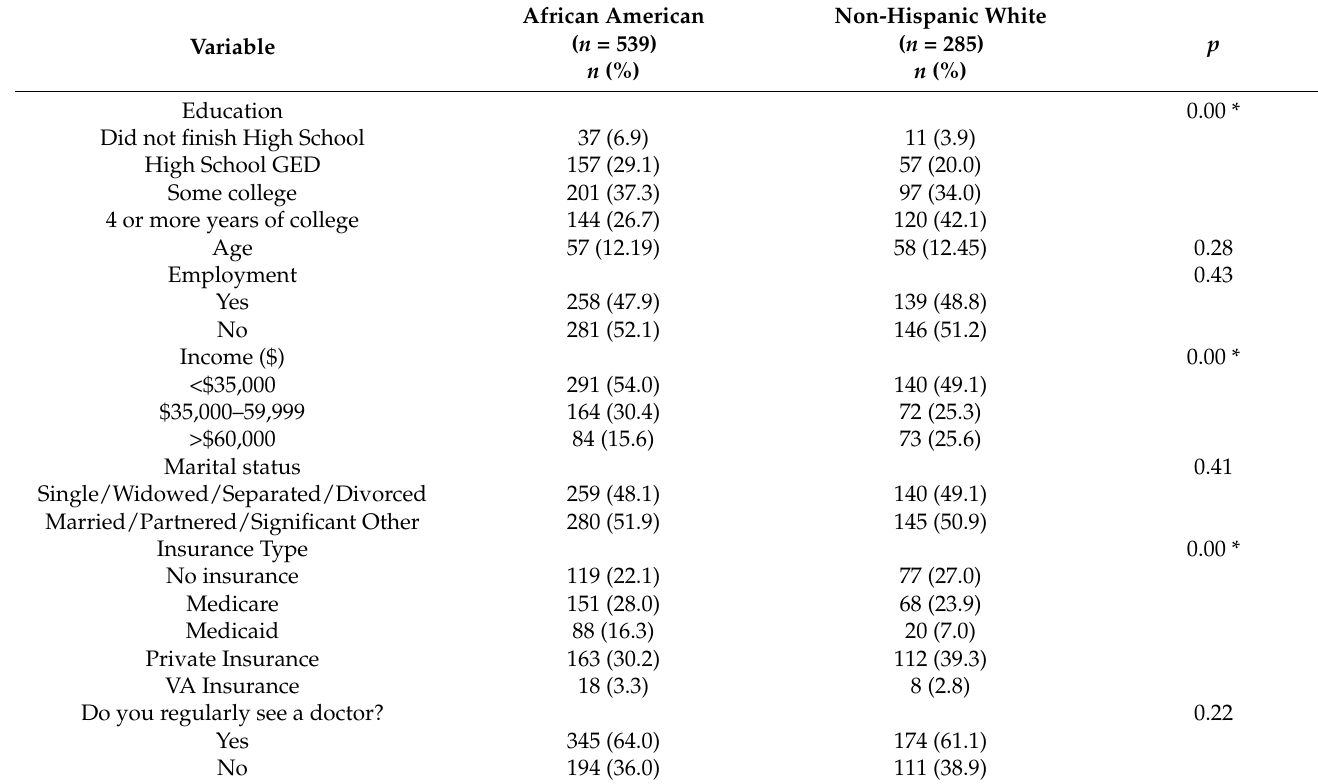
Table 2. Main variable comparisons by race/ethnicity ( N = 824).